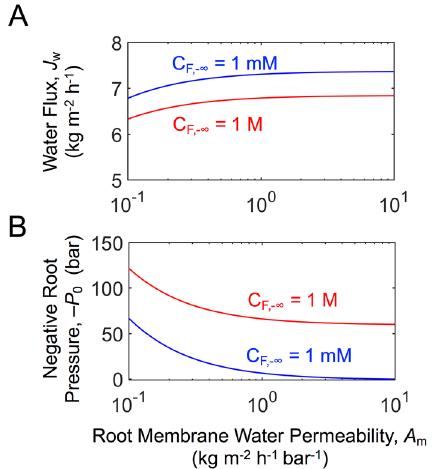
Figure 4. Impact of water permeability of root membrane on water flux ( A ) and on negative pressure at the xylem-root membrane interface (B) for two different feed solute concentrations ( C F, −∞ ) of 1 mM and 1 M NaCl. C X = 0.5 mM NaCl is considered such that the maximum concentration of solutes in the xylem does not exceed 5 M. And, d X = 0.01 m and A R = 100 are